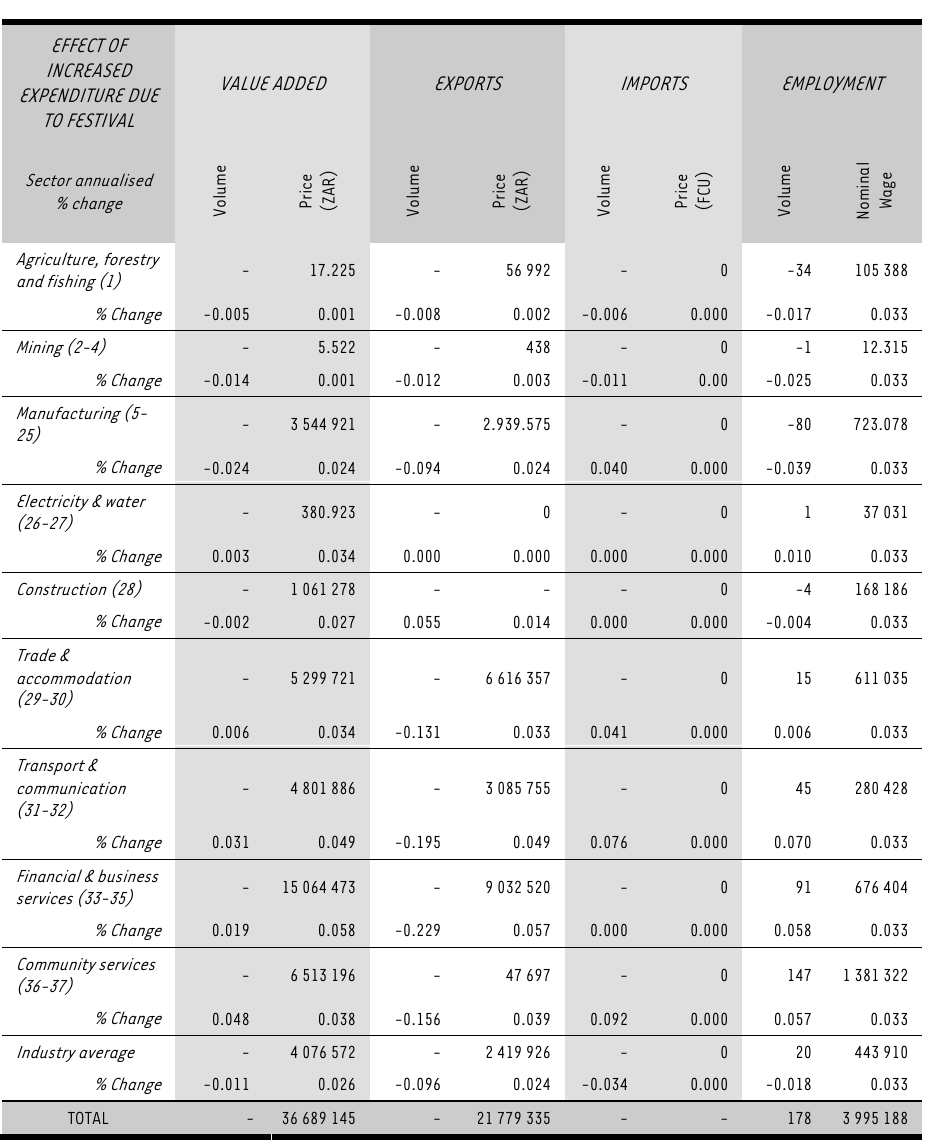
TABLE 10: Aggregate sectoral level impacts (structural effects for the regional model only) –